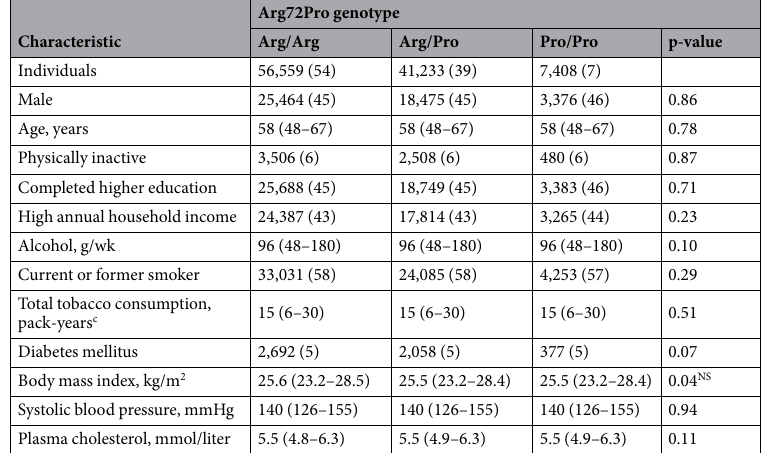
Table 1. Baseline characteristics according to TP53 Arg72Pro genotype in individuals in the general population. Data are expressed as number and percentage for categorical values and median and interquartile range for continuous values. Total tobacco consumption was calculated for current and former smokers only. P-values were calculated using Cuzick’s test for trend, and the nominal p-values are shown without prior adjustment for multiple comparisons. NS Insignificant after Bonferroni correction for 12 multiple tests. Required p-value = 0.004 ( =